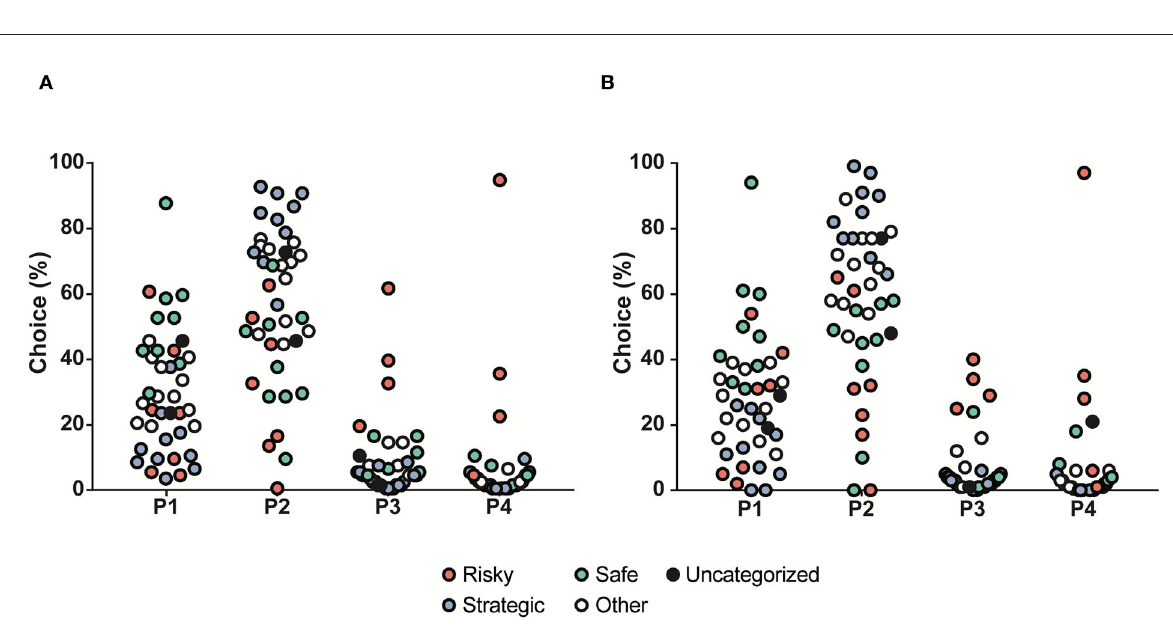
FIGURE5 Distribution of the choices (%) in all rats ( n = 40) tested during (A) rGT2 and (B) rGT3, with choices in percent on the y -axis and the four available choices on the x -axis. The individuals are colored by the rGT group in rGT1 into safe (green, n = 9), strategic (blue, n = 10), risky (red, n = 7), other (white, n = 12), and individuals that did not advance past training in rGT1 (black, n =